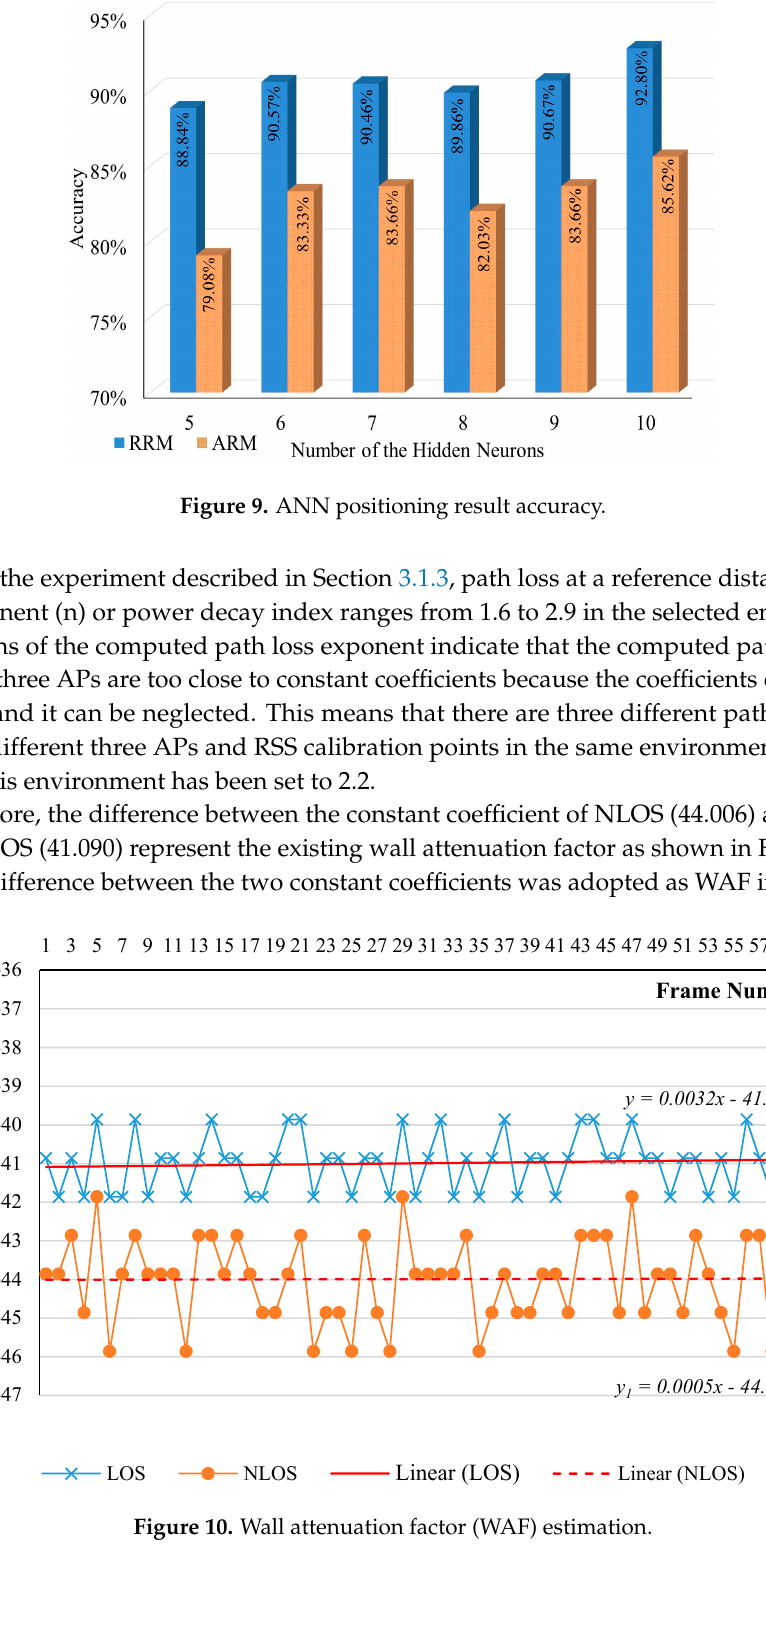
Figure8. KNN positioning result accuracy.